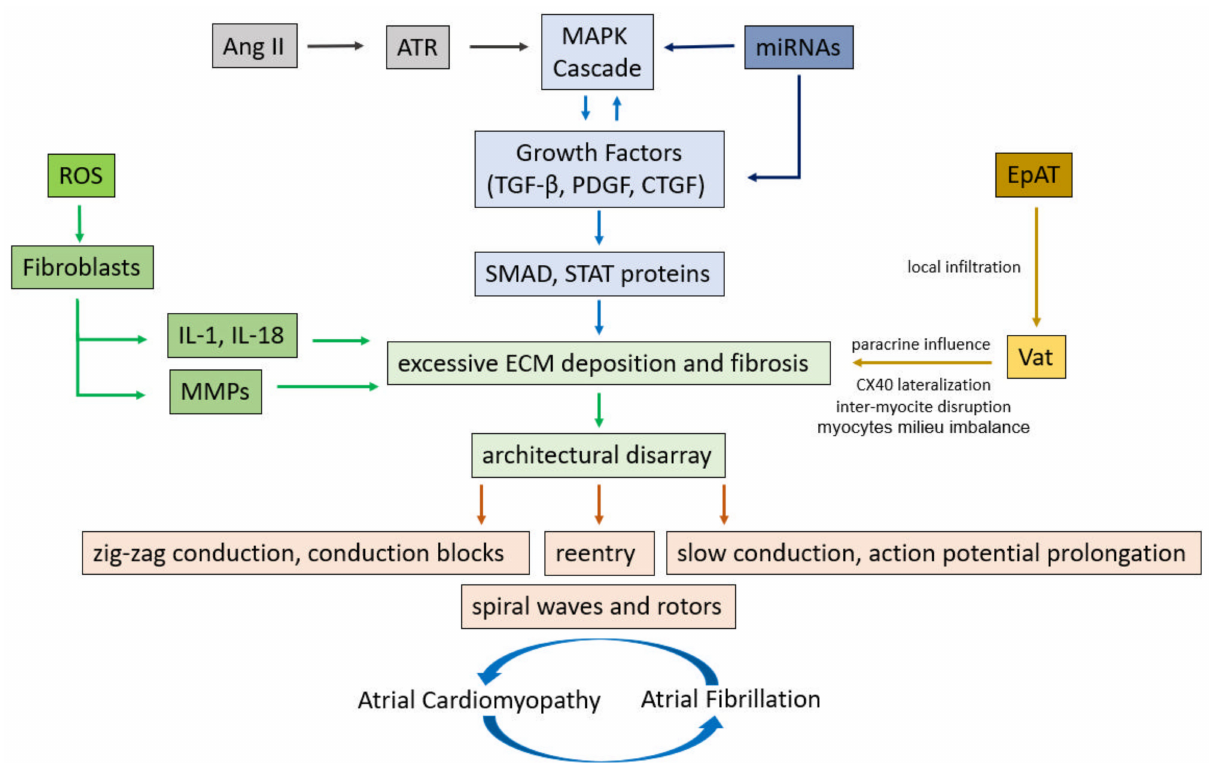
Figure 1. Cellular and molecular pathways involved in the structural and electrical remodeling leading to atrial fibrillation. Ang II = Angiotensin II, ATR = Angiotensin receptor, MAPK = mitogen-activated protein kinase, TGF- β = Transform- ing growth factor- β , PDGF = platelet derived growth factor, CTGF = connective tissue growth factor, SMAD = Small mothers against decapentaplegic, STAT = signal transducer and activator of transcription, ROS = reactive oxygen species, IL-1 = interleukin-1, IL-18 = Interleukin-18, MMPs = matrix metalloproteinases, ECM = extra cellular matrix, miRNAs = mi- croRiboNucleicAcids, EpAT = Epicardial Adipose Tissue, VaT = Visceral adipose